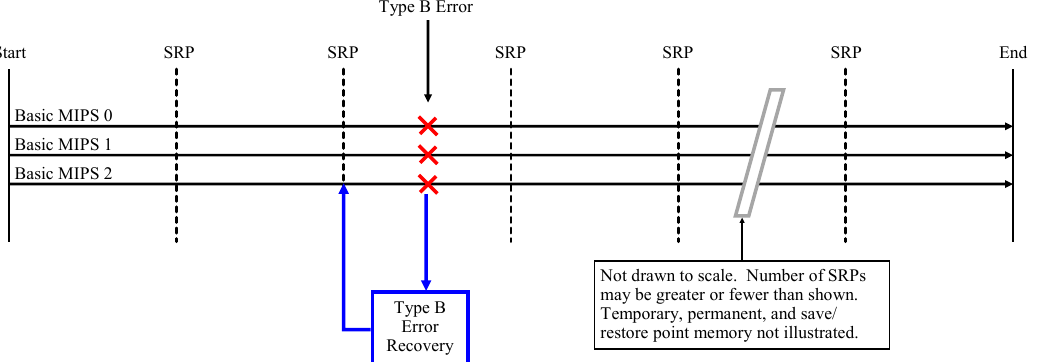
Figure A4. TMR MIPS Type B error timing